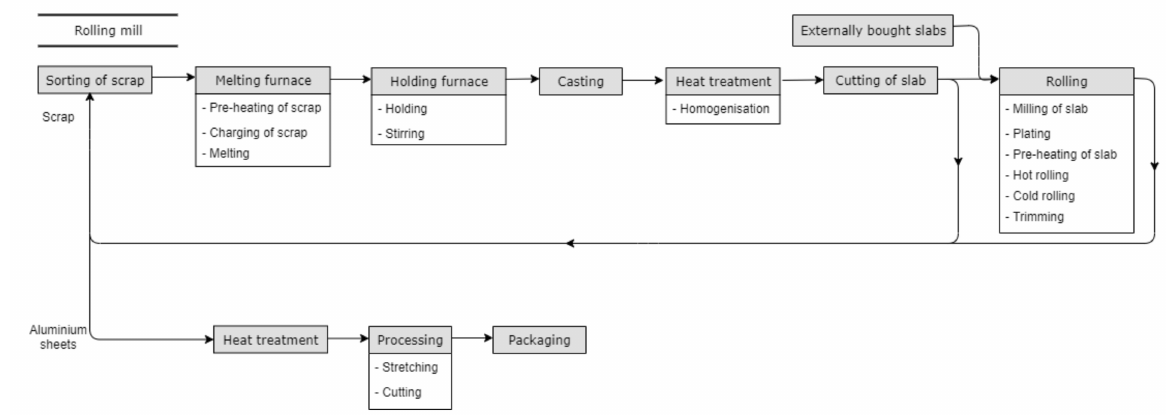
Figure 2. Production processes associated with rolling mills.